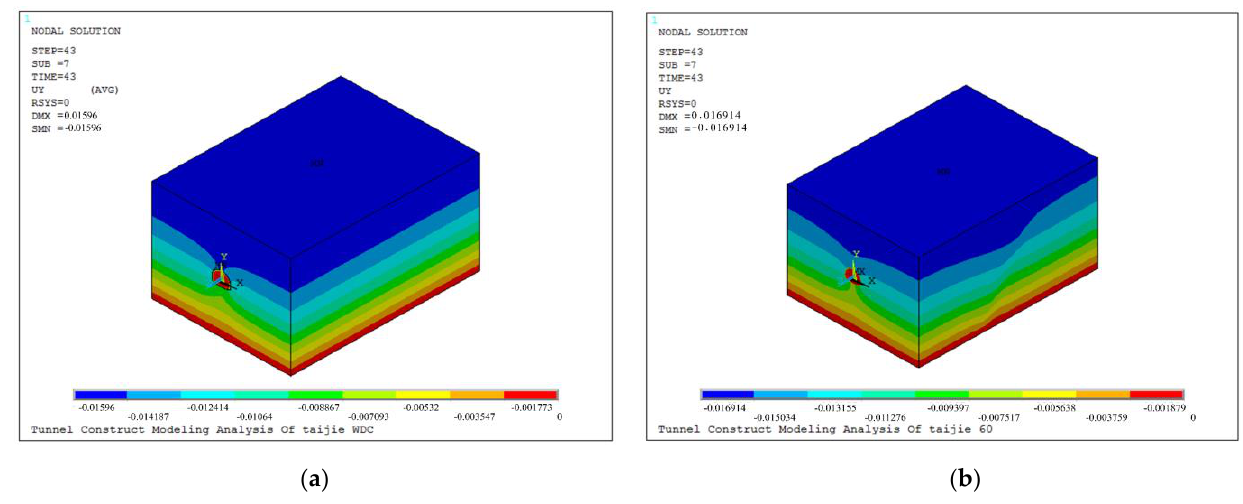
Figure 16. Comparison of the vertical displacement of strata: ( a ) no fault and ( b ) 60° fault dip.